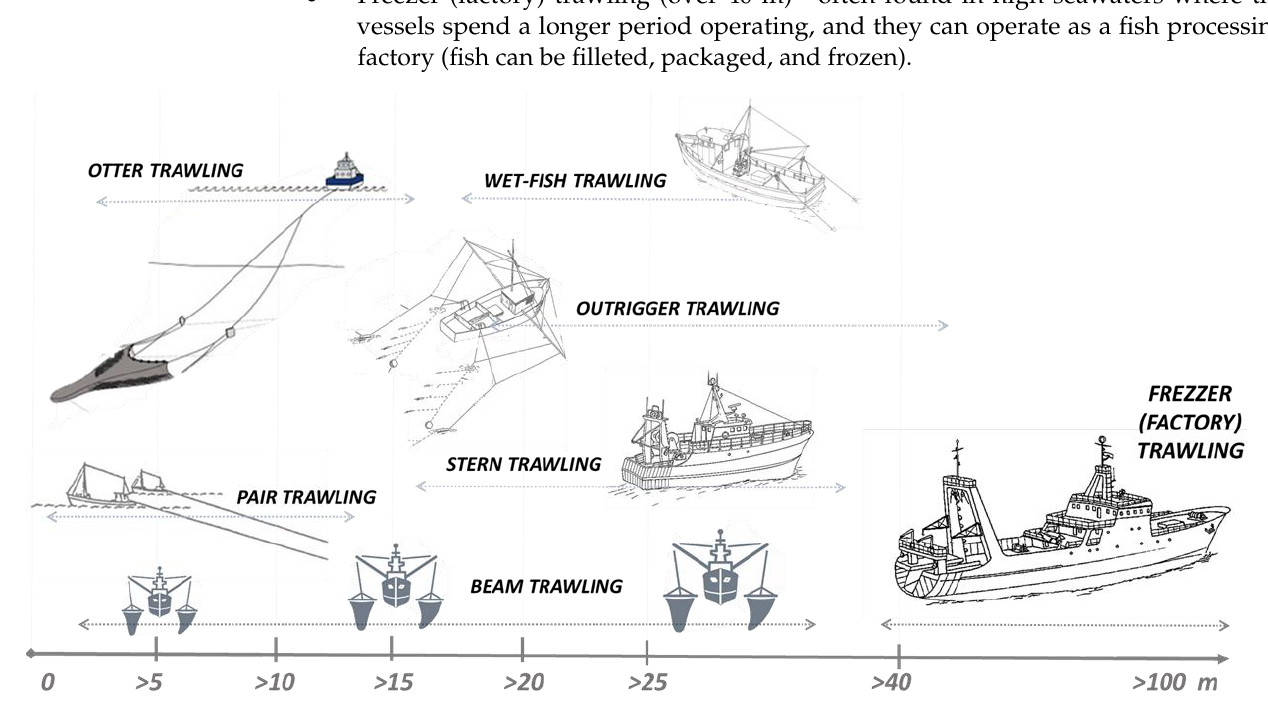
Figure 1. Classification of trawlers by the type of gear and standard length.